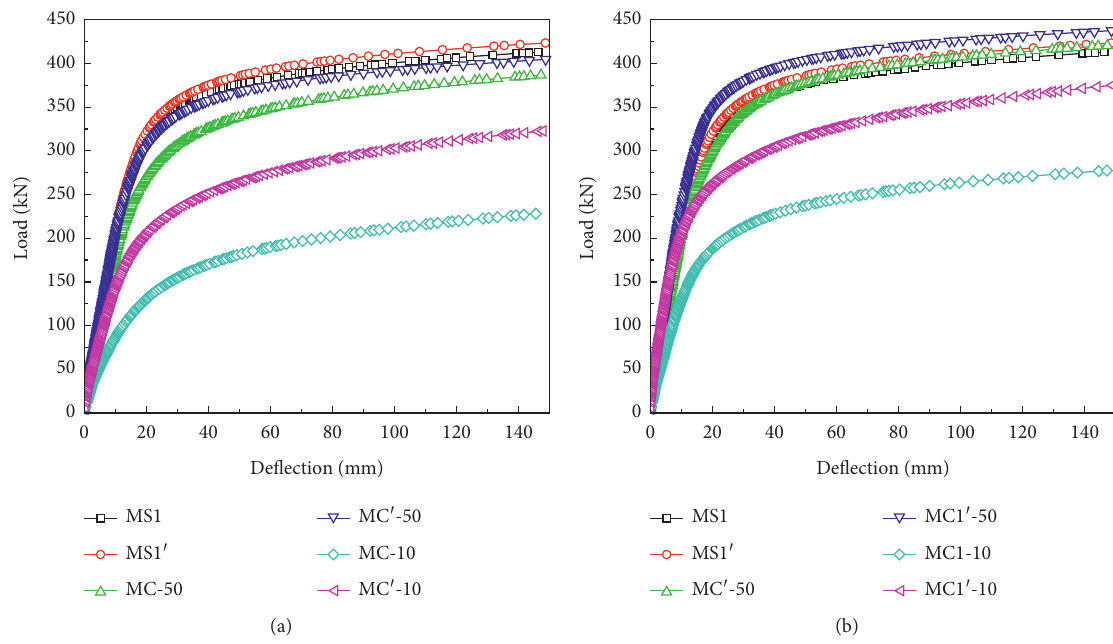
Figure 18: Load-deflection curves of the TGCB models with and without crossbeams: (a) outer girder G1; (b) inner girder